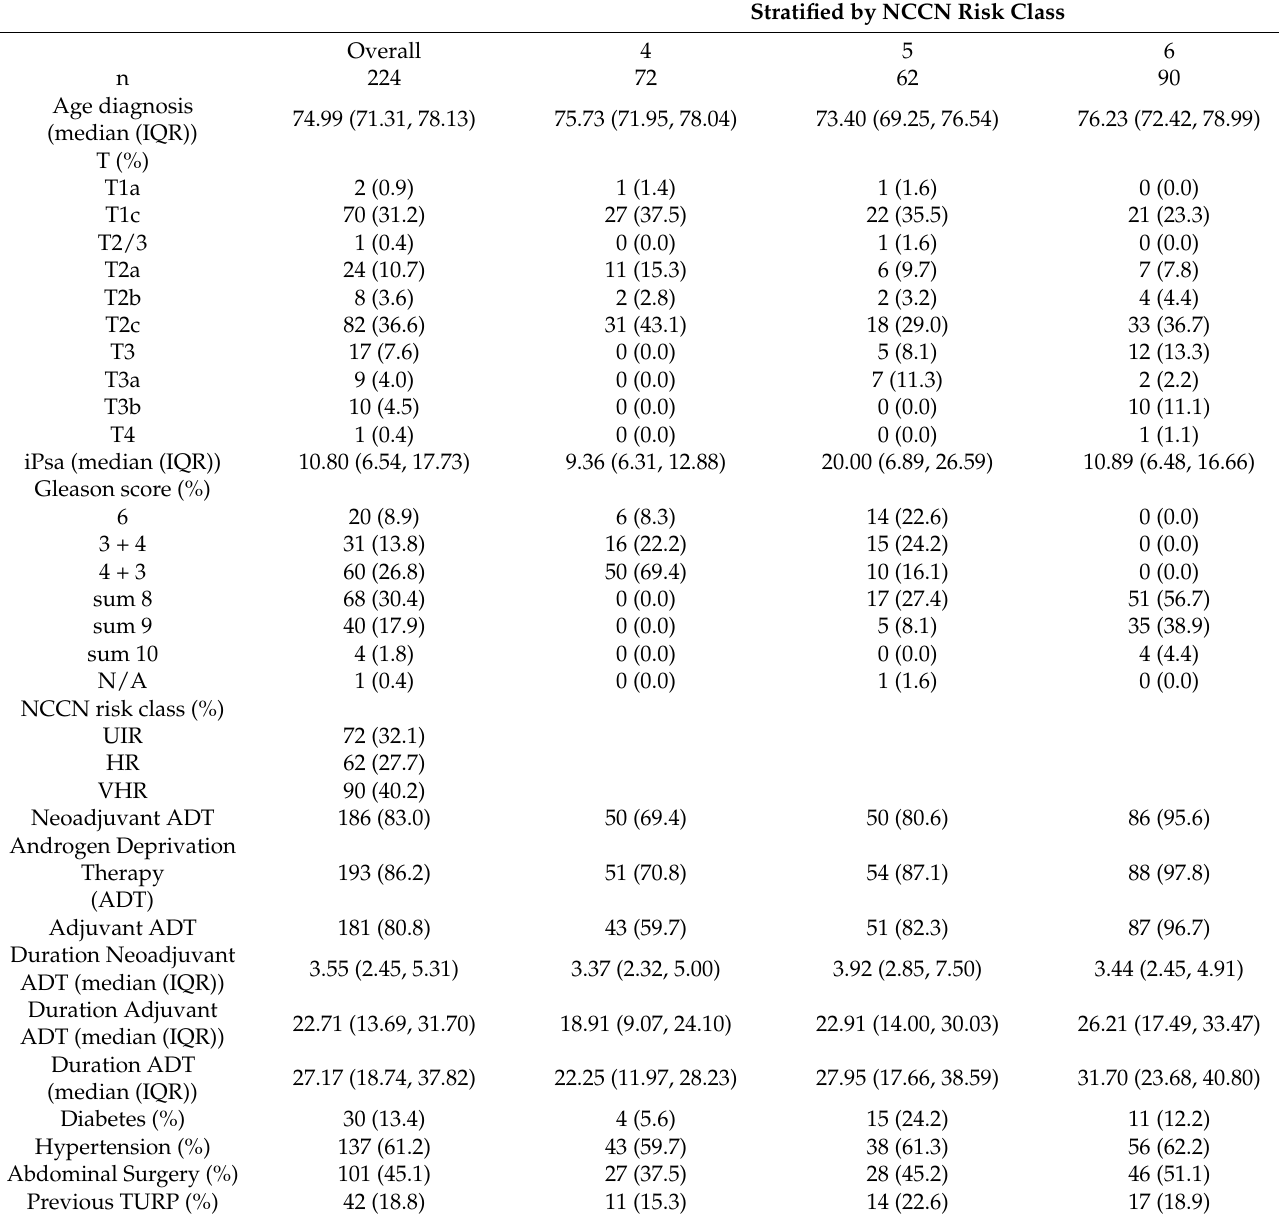
Table 1. Patients and treatment